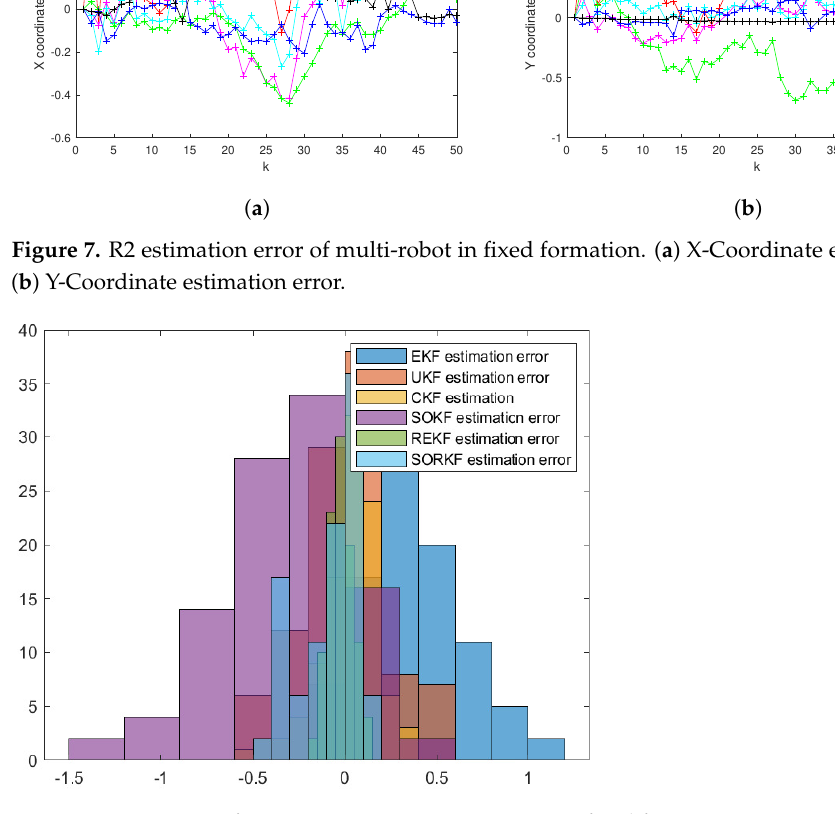
Figure 8. Histogram of R2 positioning estimation error in fixed